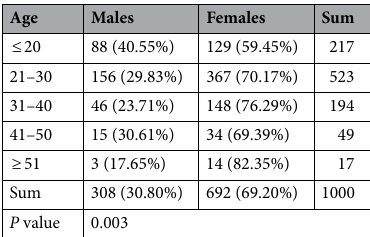
Table 1. Distribution of males and females in different age groups. There was a significant difference in the proportion of gender among age groups. Sum: